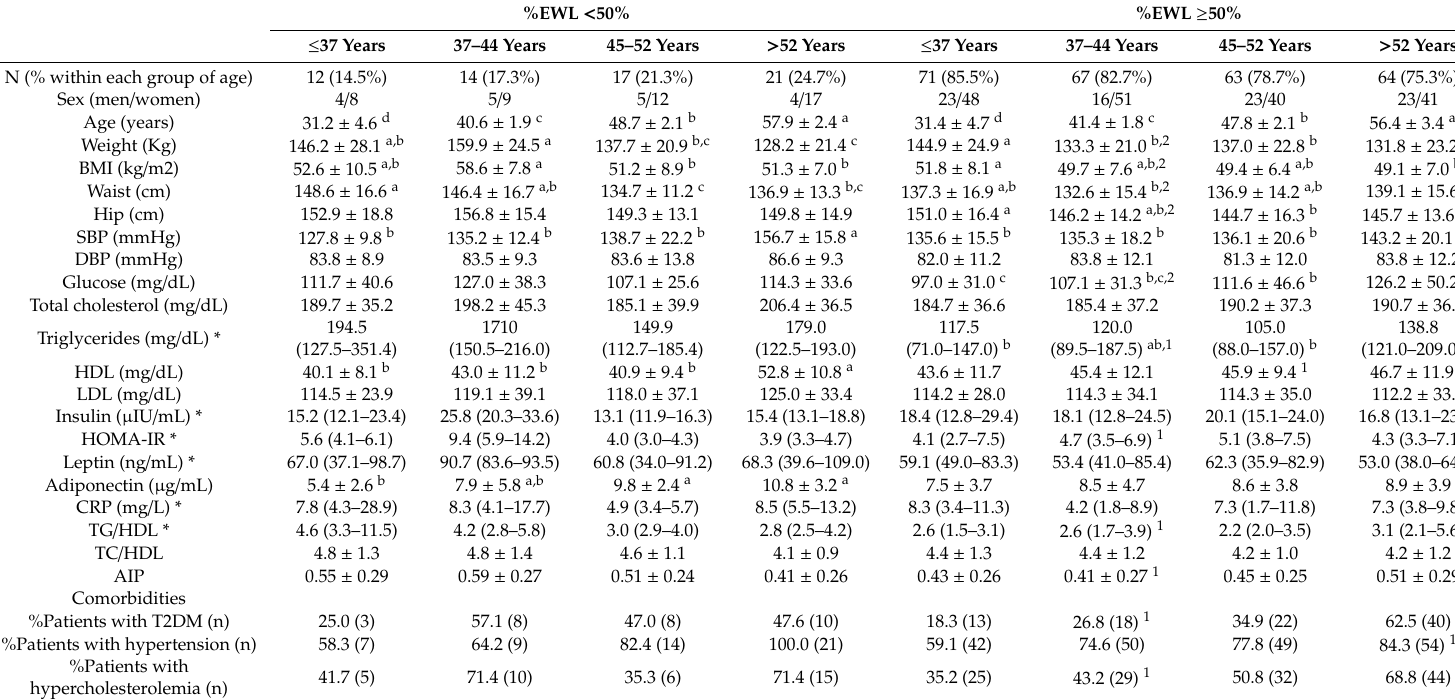
Table 5. Baseline characteristics of patients with morbid obesity classified according to the percentage of excess weight loss (%EWL) and